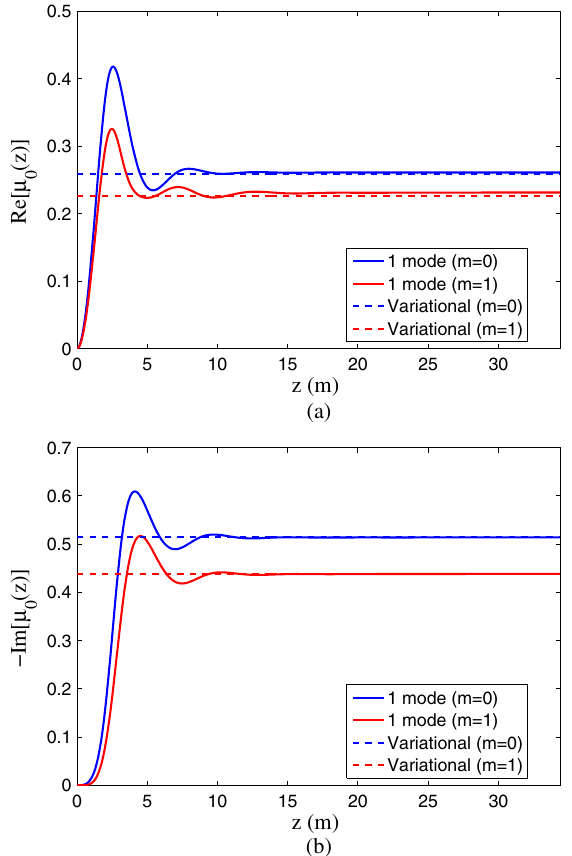
FIG. 5. Gain functions for an FEL driven by a matched beam mode: data for (Set 2 parameters) and seeded with a GL 0 m m ¼ 0 (blue) and m ¼ 1 (red) are shown. Figure 6 also refers FIG. 6. (a) Real and (b) negative imaginary parts of the scaled, ð z Þ ¼ (cid:17) ð z Þ = ð 2 (cid:13) Þ for a GL k seed mode local growth rate (cid:17) to this configuration. Both 1-mode (solid curves) and 5-mode m u 0 0 m (solid lines, based on single-mode data) compared to the varia- results (symbols) are included. In terms of the radiation power, eigenmode (dashed tional values for the growth rate of the E the rms deviation of the latter from the former is about 1% (2%) 0 m ( GL ) lines). Results for m ¼ 0 (blue) and m ¼ 1 (red) are shown. for the GL 00 01